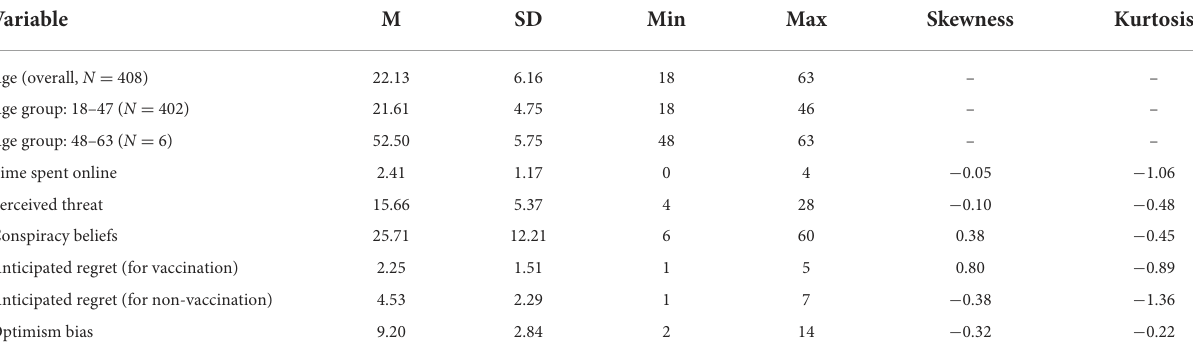
TABLE 1a Descriptive statistics for the main variables (overall sample, N = 408).